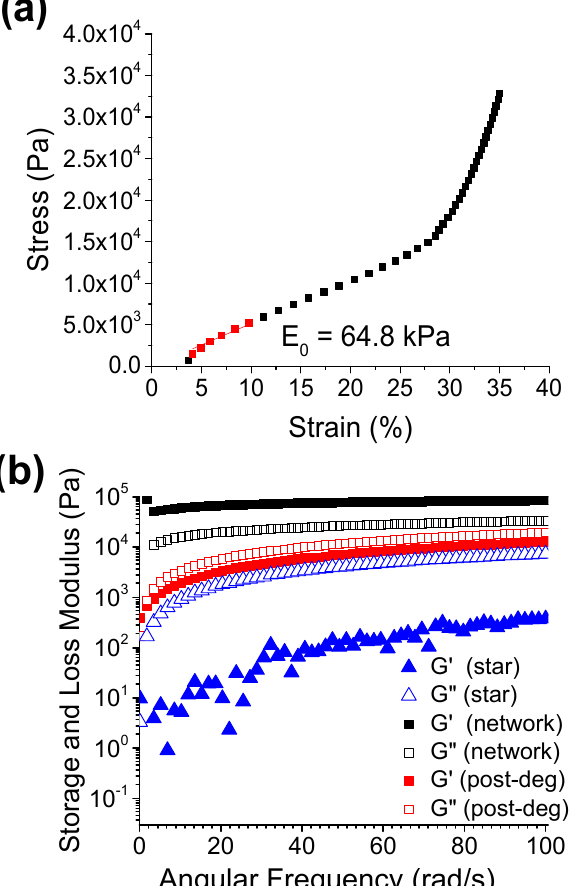
Figure 2. ( a ) Compression test of PBA elastomer at room temperature. ( b ) Frequency sweep of the polymer stars (blue), crosslinked network (black), and degraded network recast as a film (red) from a range of 0.1 to 100 rad/s with a 1 N normal force and T = 25 °C.